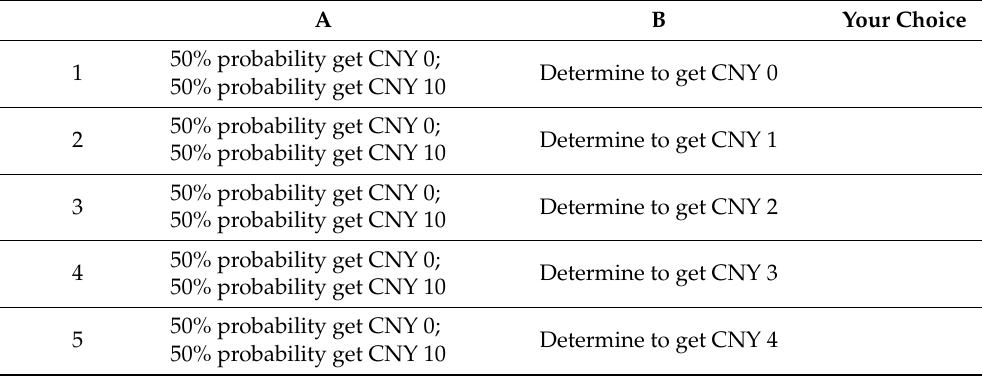
Table A1. Risk preference